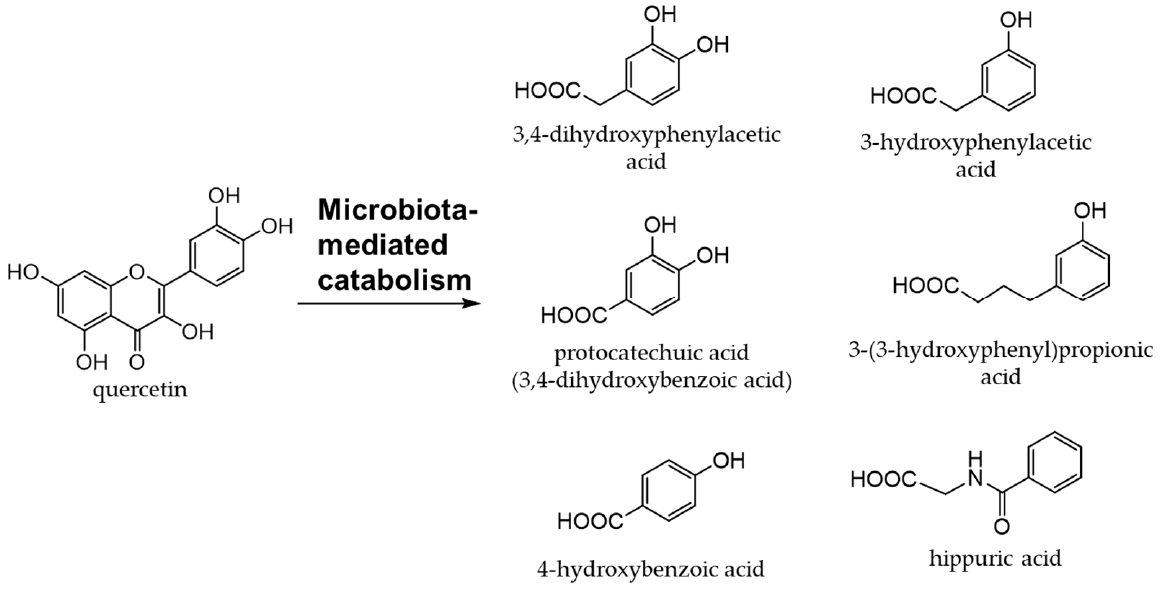
Figure 7. Quercetin catabolites by intestinal bacteria.